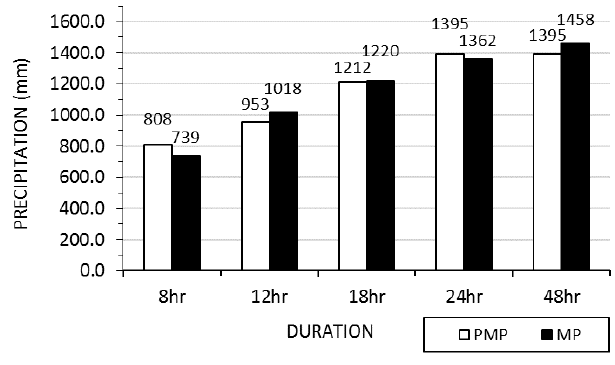
Figure 8. PMP and RCM_PMP at Gangneung.